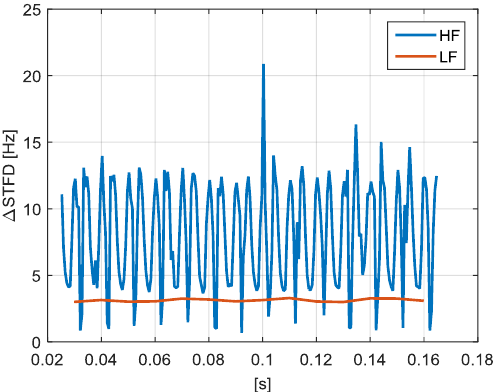
Figure 13. Case study 2: Δ STFD at low-frequency (0 ÷ 2 kHz, red line) and at high-frequency (2 ÷ 150 kHz, blue line) obtained by the instantaneous approach. Energies 2017 , 10 , 1633